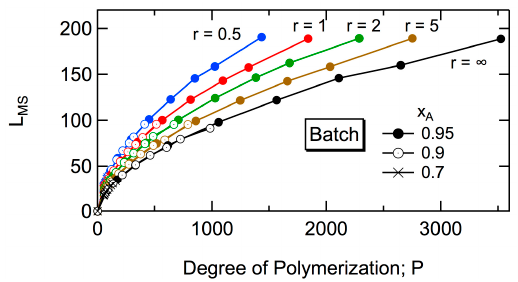
Figure 16. Relationship between L MS and P with various r -values at x A = 0.95 (filled circle), 0.9 (open circle), and 0.7 (cross) for batch polymerization.